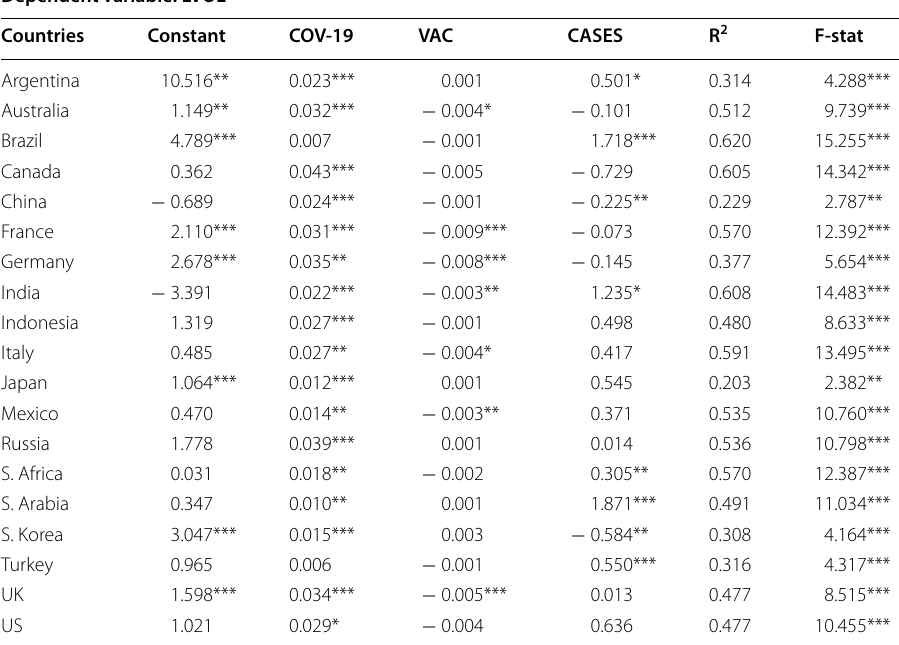
The standard errors are calculated using the Newey–West variance–covariance matrix. ***, **, and * indicate statistically significant coefficients at 1%, 5%, and 10% levels,